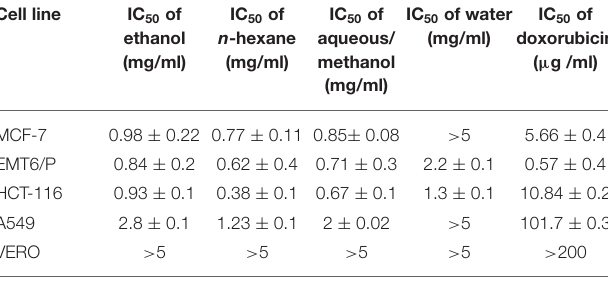
TABLE 7 | The IC 50 of ethanol, n -hexane, aqueous/methanol, and water extracts of barley bran using various cell lines in comparison to the normal Vero cell line and to doxorubicin * .